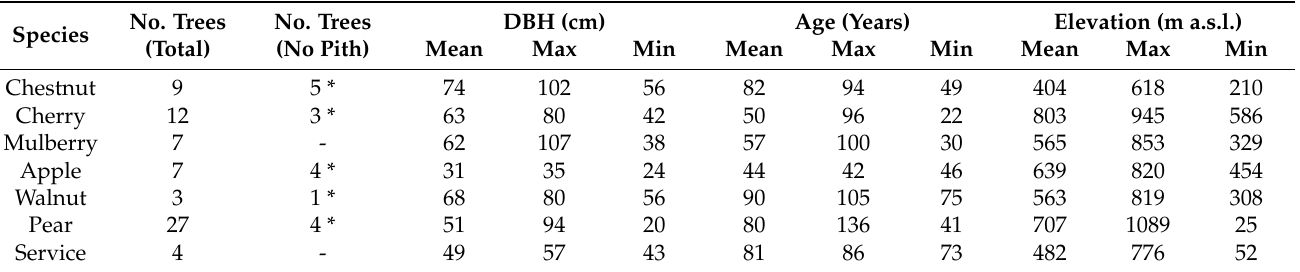
Table 4. Statistics of fruit trees analyzed through dendrochronology methods. The cores without stem pith (asterisks) were not used for dendrochronology